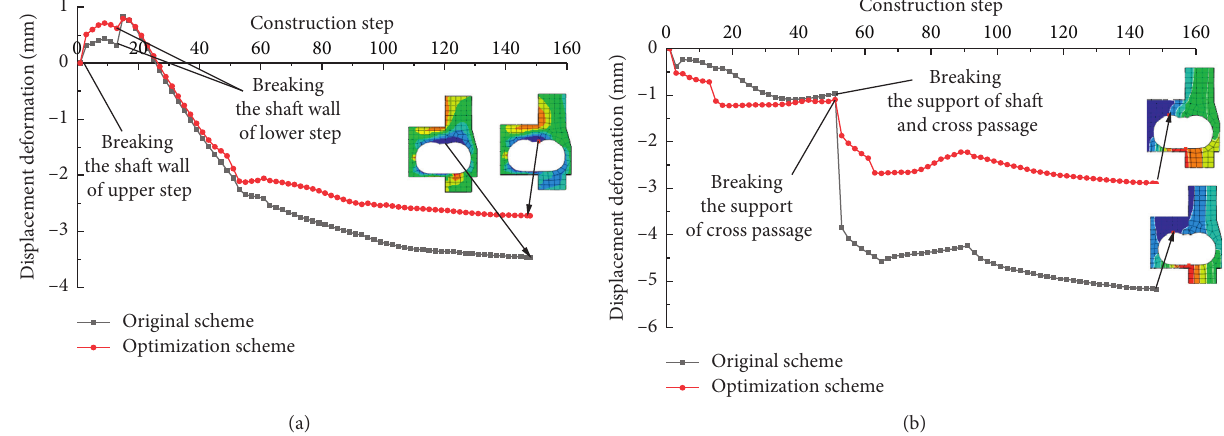
Figure 19: Comparison of displacement and deformation of support structure of cross passage of ingate arch roof: (a) horizontal dis- placement comparison; (b) vertical displacement comparison.